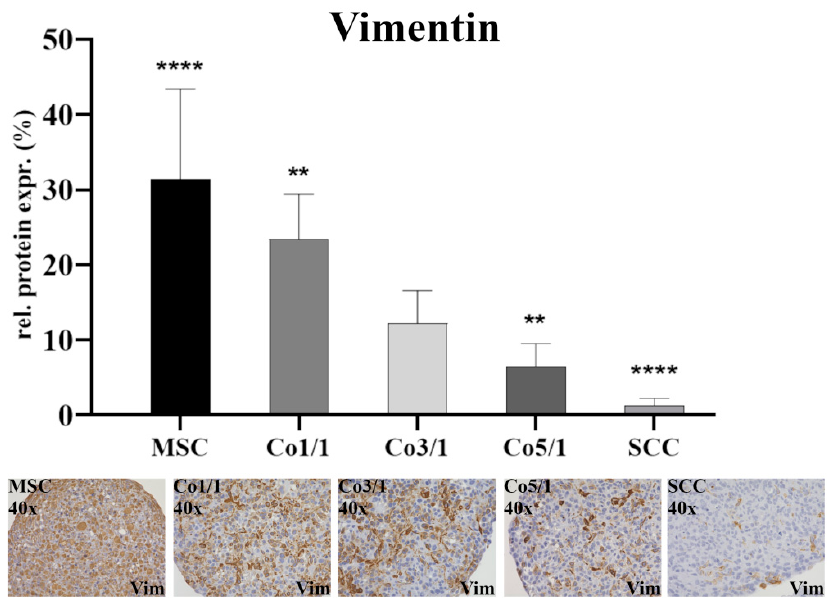
Figure 1. Immunohistochemical staining of vimentin in MSCs, Co1/1, Co3/1, Co5/1, and SCCs; magnification 40×. **** = p ≤ 0.0001, ** = p ≤ 0.01.